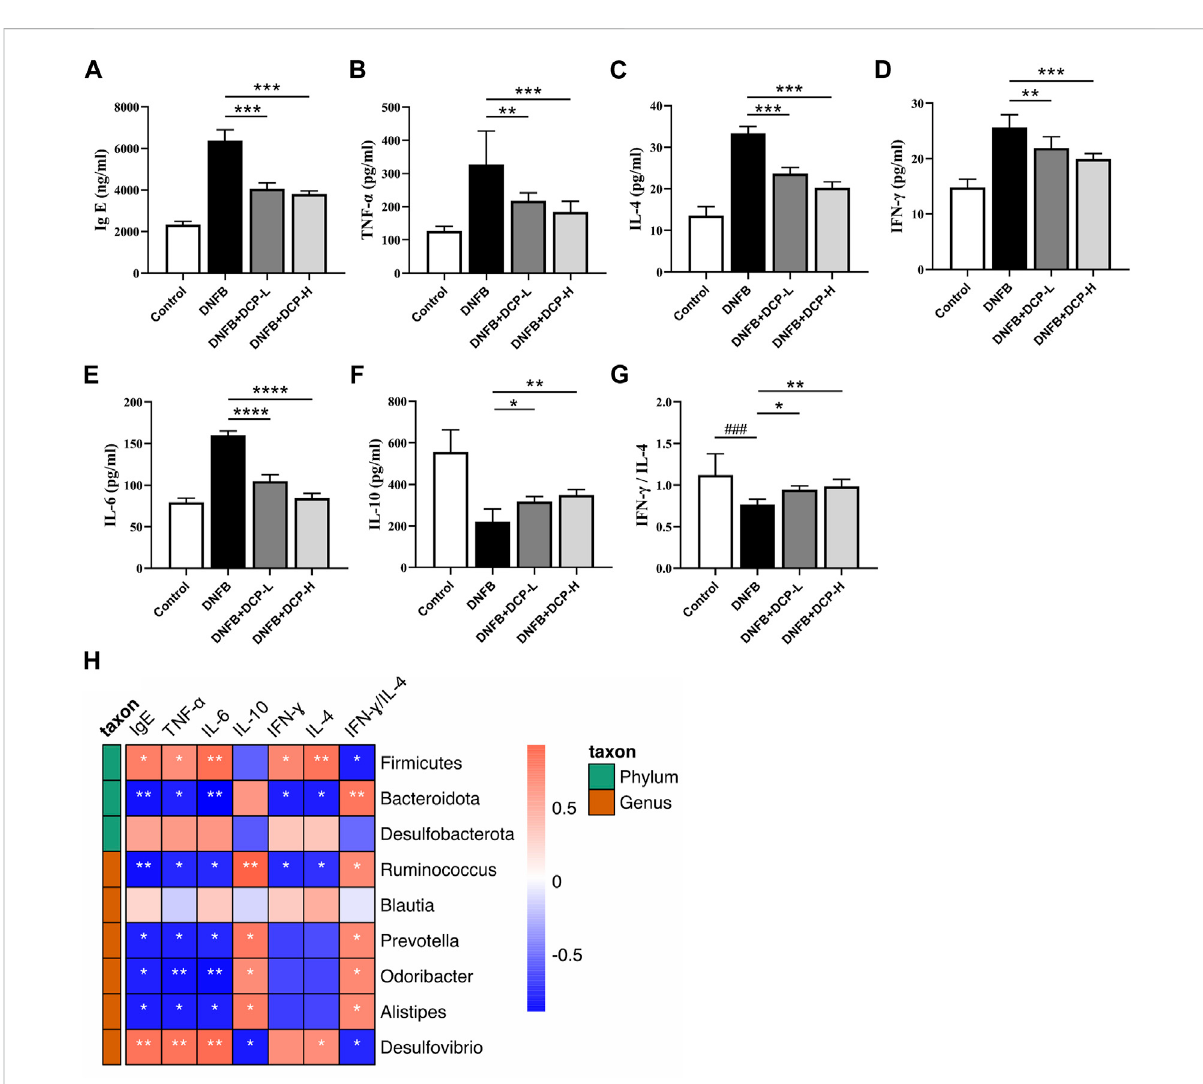
FIGURE 6 Effect of DCP on in fl ammatory cytokines and total serum IgE and its correlation with gut bacterial genera. (A) Serum concentrations of IgE; (B – F) Quantitative analysis of in fl ammatory cytokines in mouse dorsal skin; (G) The ratio of IFN- γ /IL-4; (H) Heatmap of correlation between level of cytokines and relative abundance of gut bacterial genera. Each point represents the mean ± S.E.M. of six experiments. ** p < 0.01, *** p < 0.001 and **** p < 0.0001 vs. the DNFB (AD model) group. Red indicates positive correlation; blue indicates negative correlation. * p < 0.05, ** p <